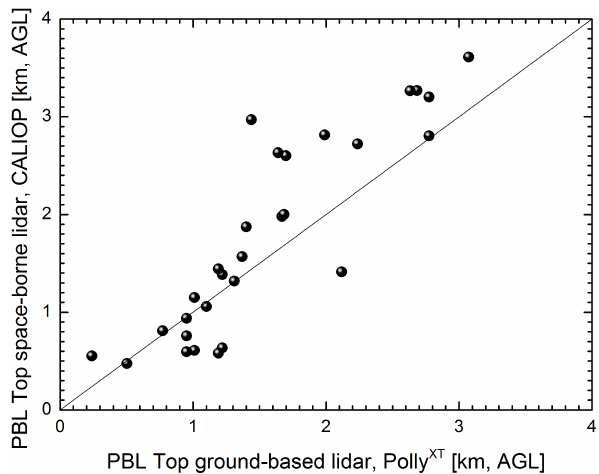
Fig. 9. PBL top comparison of 29 common PBL top height obser- vation cases for Polly XT and CALIOP